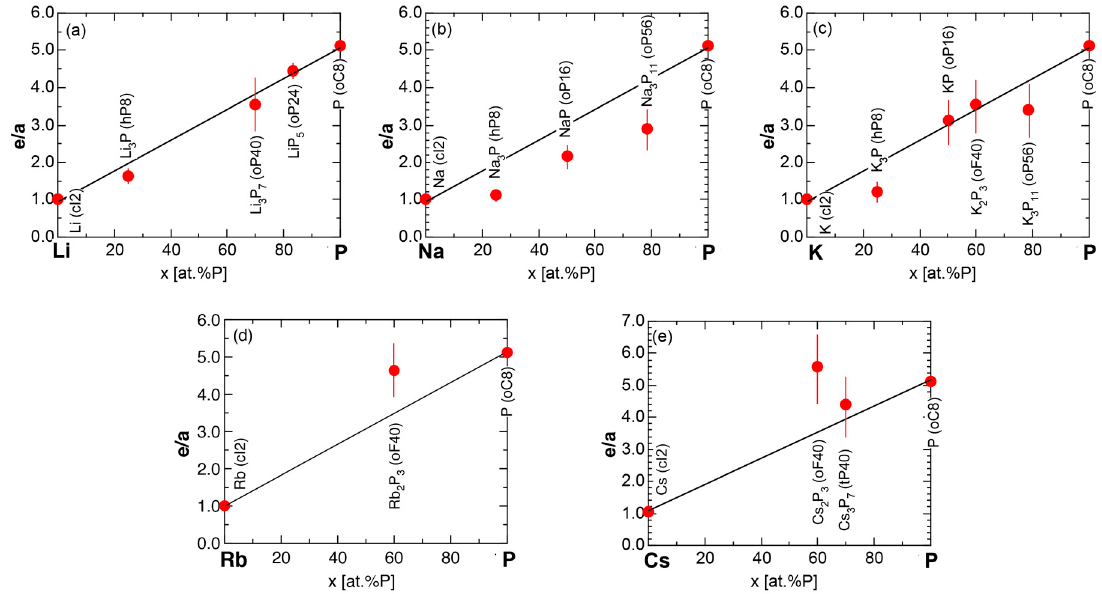
Figure 79. P concentration dependence of e/a subjected to the NFE method for ( a ) Li − P, ( b ) Na − P, ( c ) K − P, ( d ) Rb − P, and ( e ) Cs − P alloy systems [11,12].